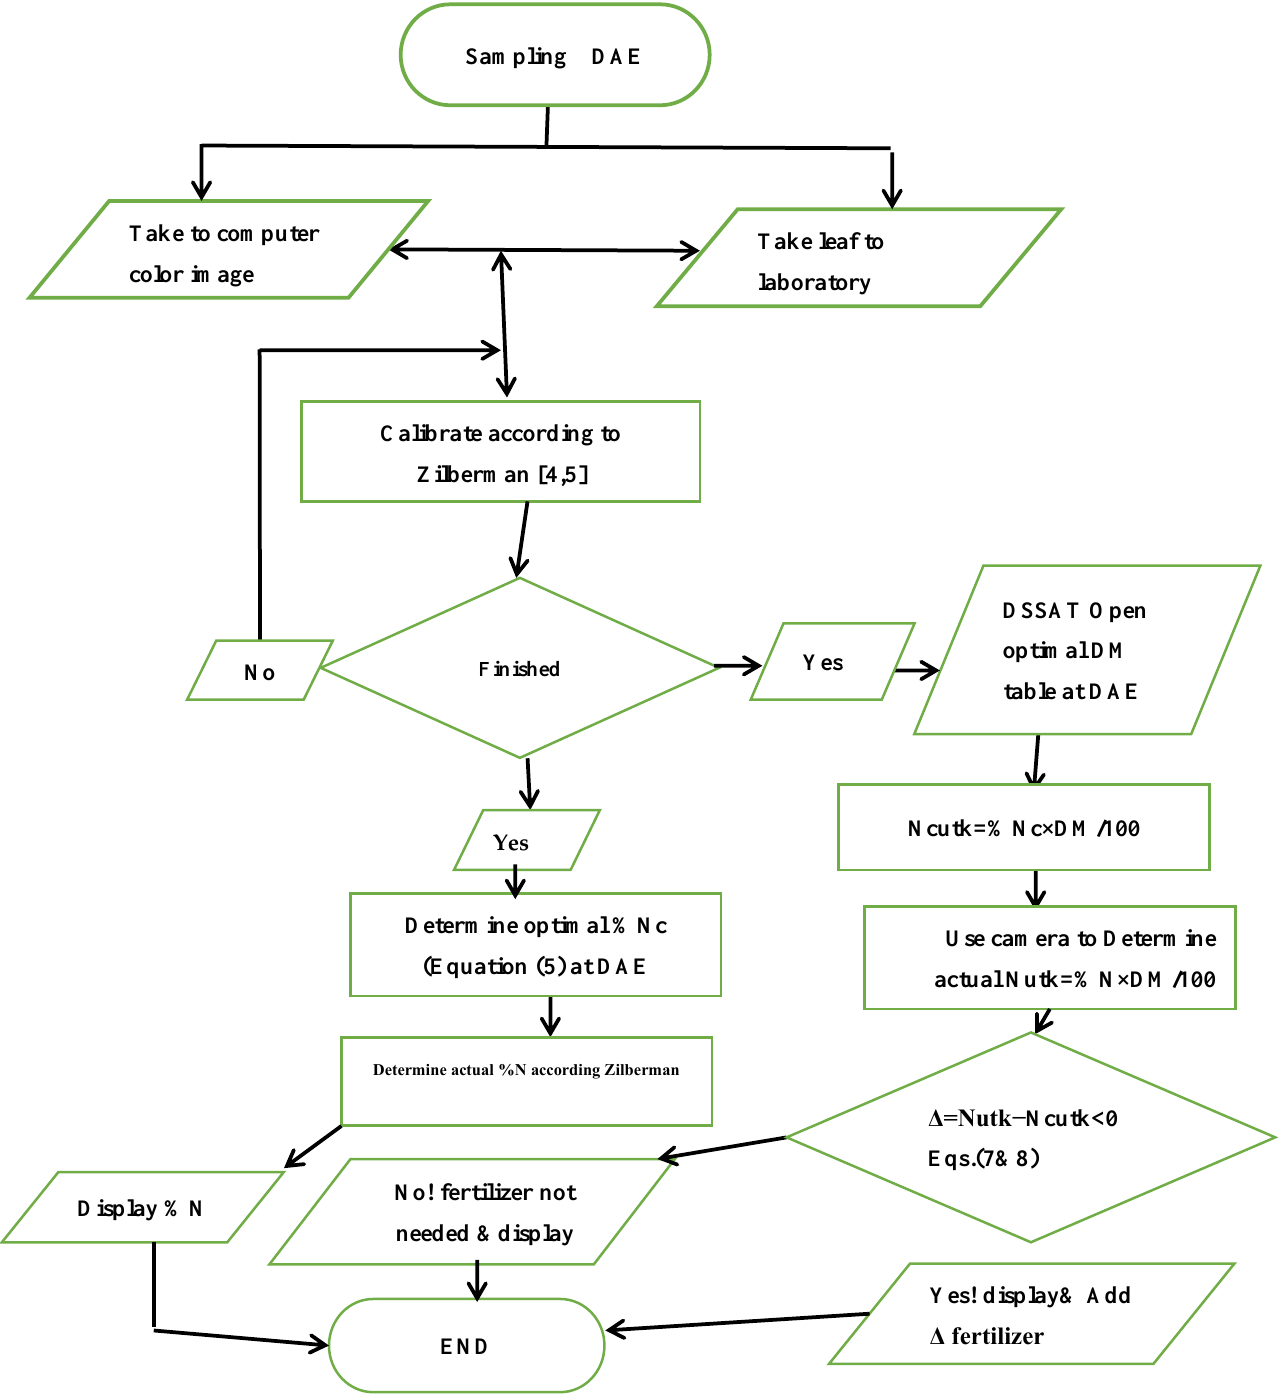
Figure 2. Flowchart describing the processing of photos taken by a smartphone (UTK = uptake ).